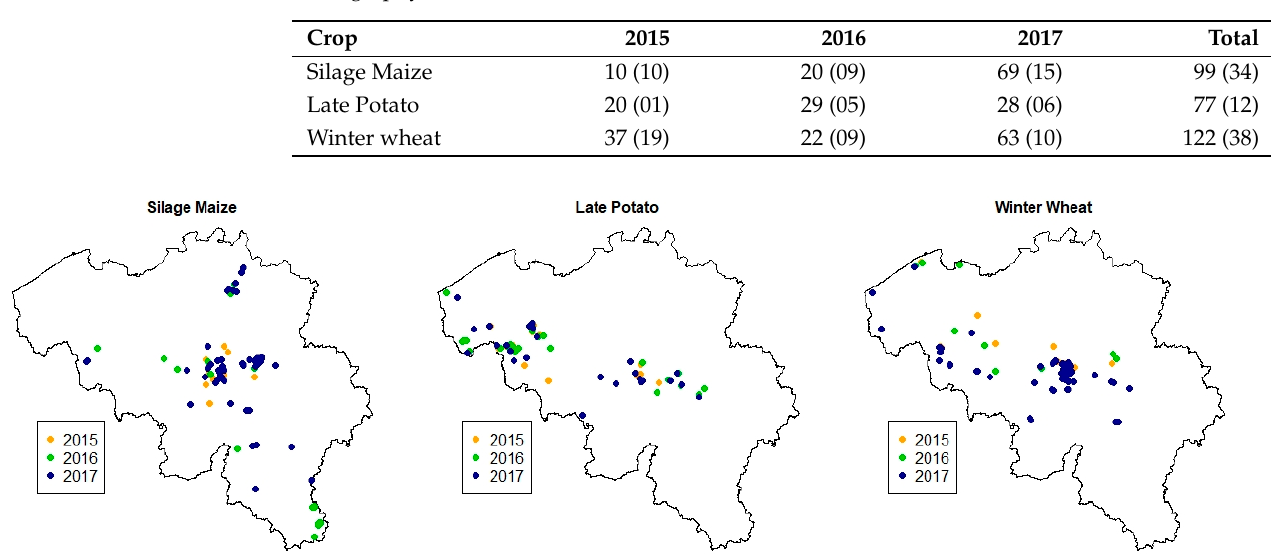
Figure 4. Extraction of pixel values contributing to the median satellite-derived biophysical varia- bles at the field scale. Example of DMC-derived fAPAR after inward buffering.